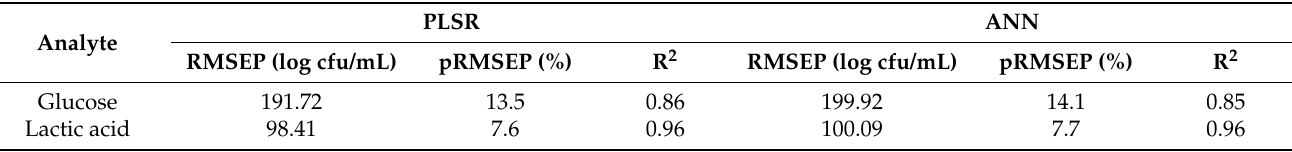
Table 2. RMSEP, pRMSEP, and R 2 values for the prediction of glucose and lactic acid with PLSR and ANN during the fermentation process of 7 g/100 mL of substrate inoculated with 6 log cfu/mL mixed strains of LPA6 and